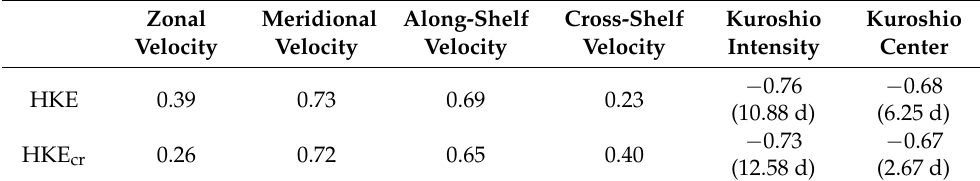
Table 2. Correlation coefficient between HKEs and